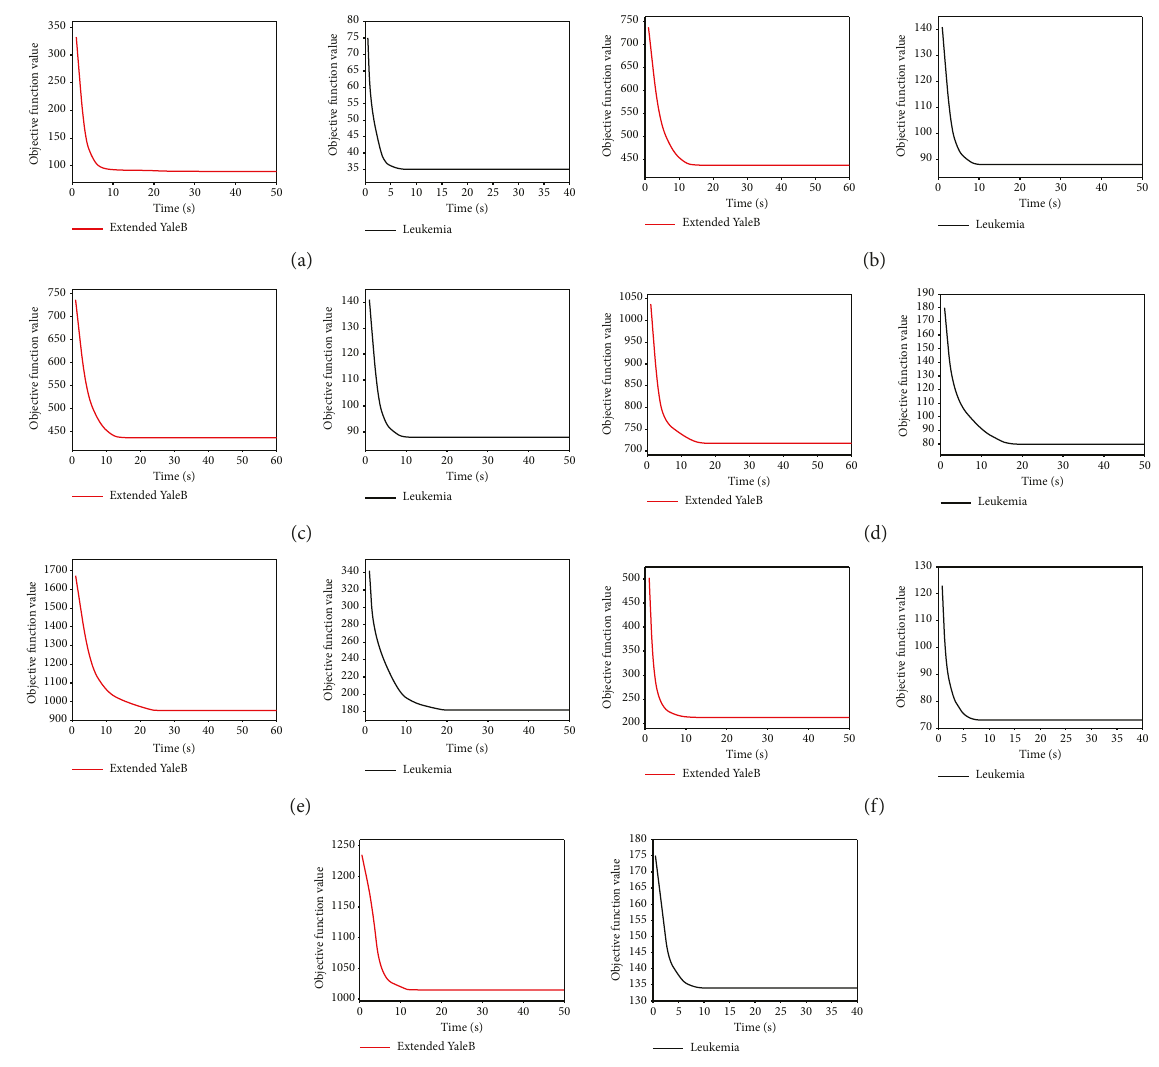
Figure 9: The curve of objective function value versus computational time on the extended YaleB and leukemia datasets. (a) RNMF, (b) semi- GNMF, (c) CNMF, (d) LCSNMF, (e) URNGE, (f) NLCF, and (g)